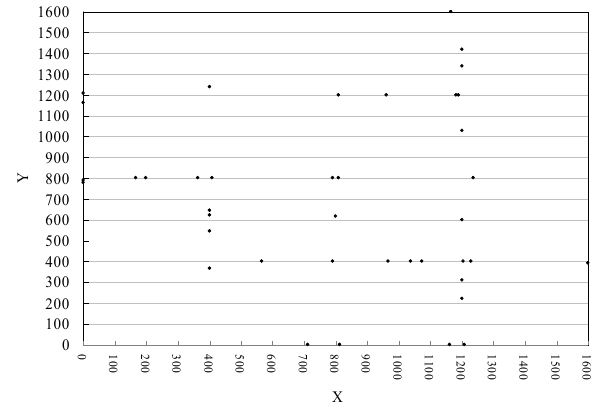
Figure 11. The snapshot of network topology when the number of nodes is 40